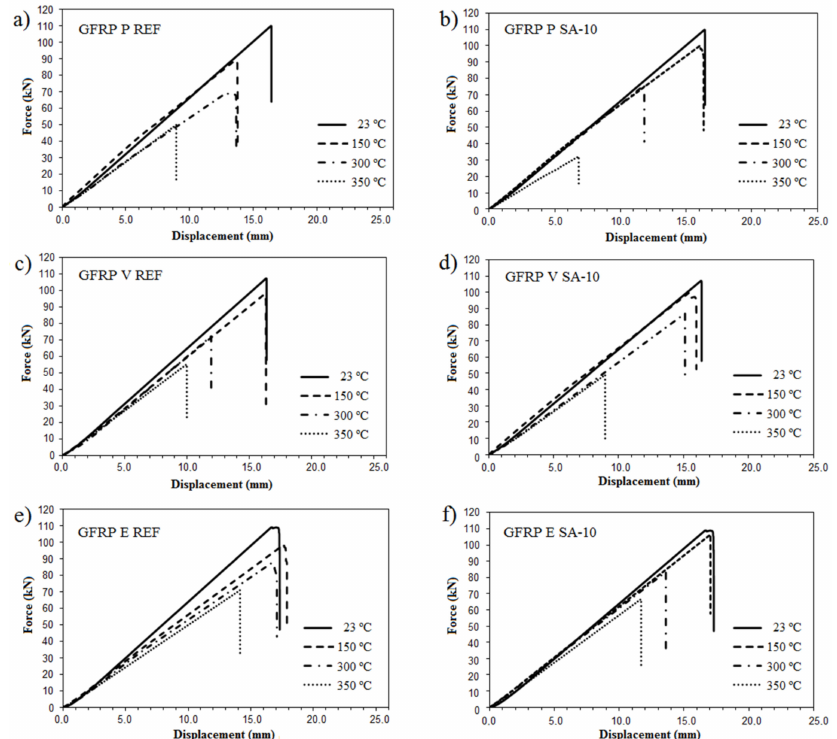
Figure 9. Relation between the force vs. displacement for samples of: ( a , b ) GFRP P, ( c , d ) GFRP V, and ( e , f ) GFRP E, for concrete REF and SA-10, respectively.